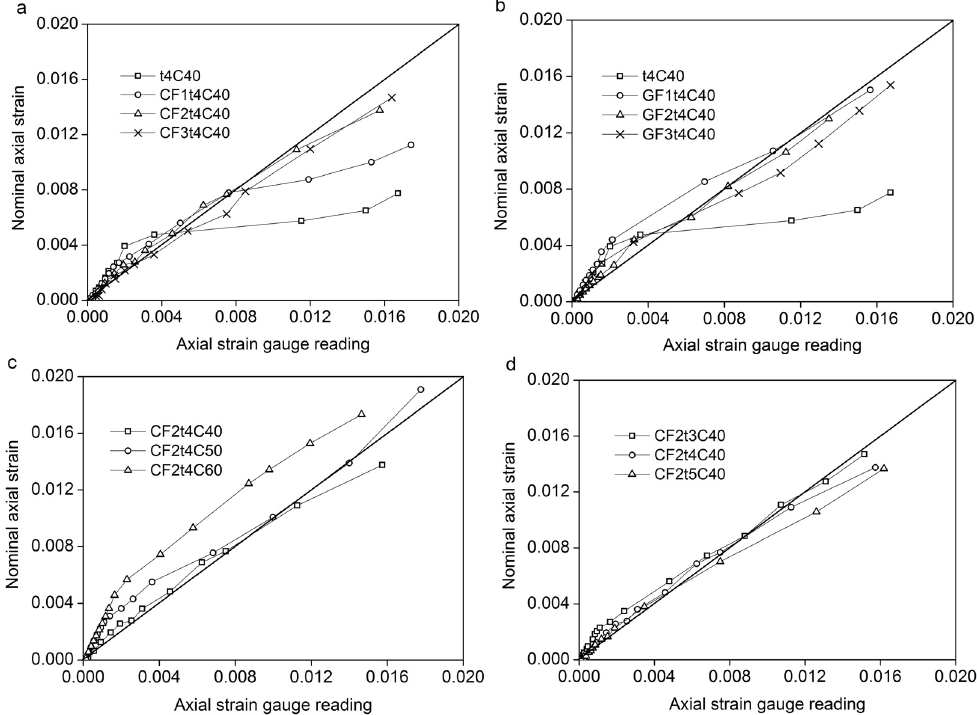
Figure 11. Comparisons between nominal axial strain and axial strain gauge